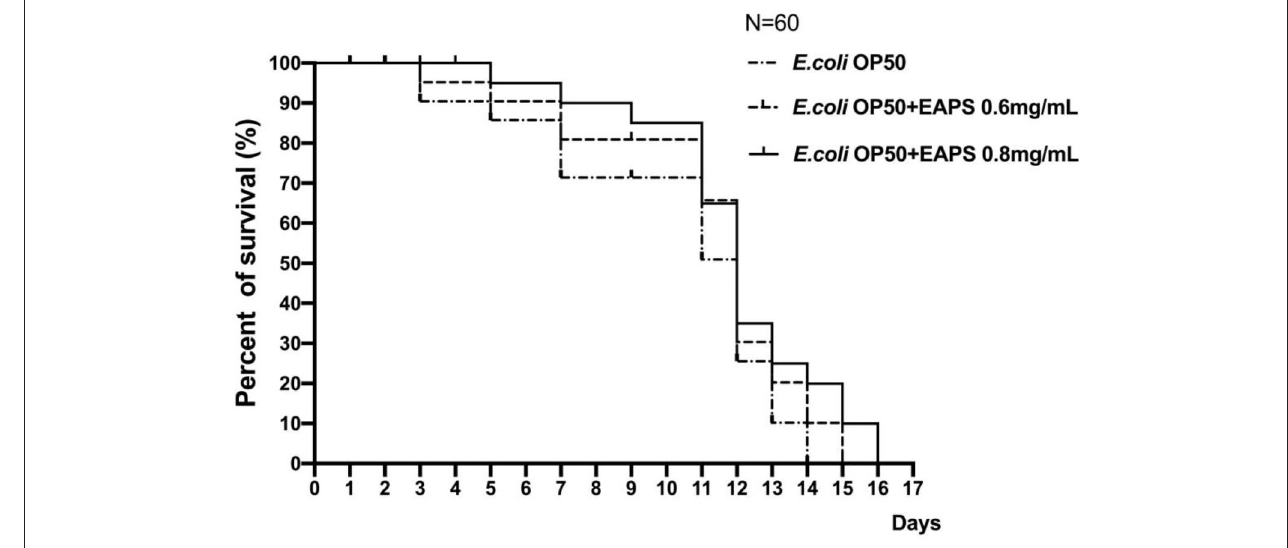
FIGURE 6 | Survival curves of Caenorhabditis elegans after treatment with EAPS.